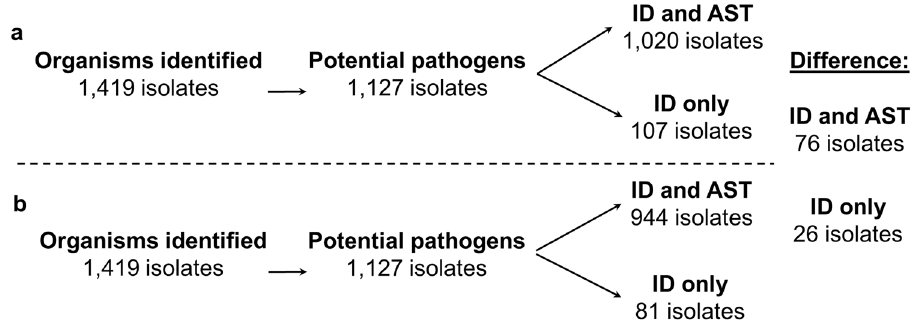
Figure 3. Comparison of wound swab reporting between ( a ) the existing OM100 semi-quantitative grading and pathogen reporting scheme and after ( b ) Q score criteria has been applied. This analysis includes the retrospective sample set with the OM100 score translated into the Q100 score.